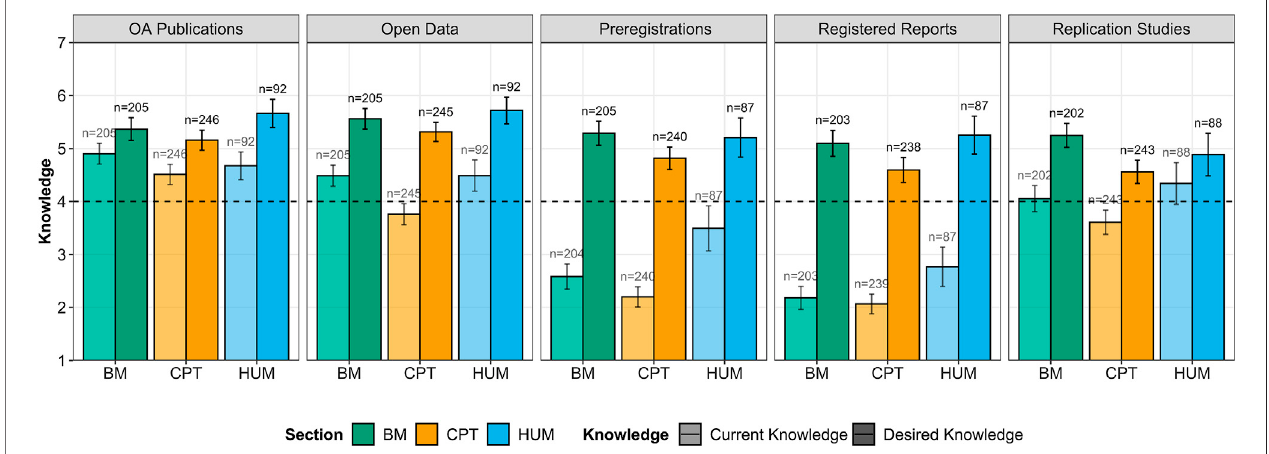
FIGURE 1 | Mean of current vs. desired knowledge about different OS practices in the different sections (BM: biology and medicine, CPT: chemistry, physics, and technology, and HUM: humanities). Dashed line represents the midpoint of the scale (i.e., 4). Error bars represent 95% con fi dence intervals (CIs).